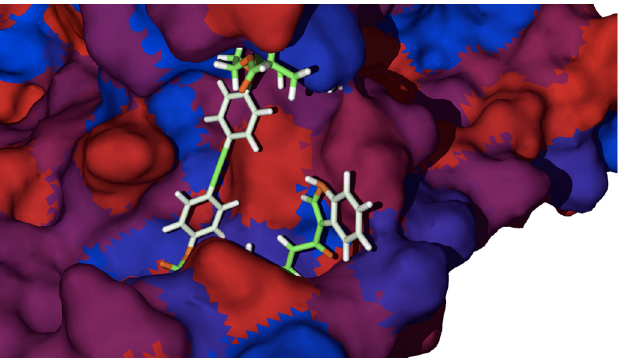
Figure 6. Hydrophobic interactions between 15 and the SARS-CoV-2-M pro . Blue and red surfaces depict a hydrophobic and hydrophilic behavior, respectively.